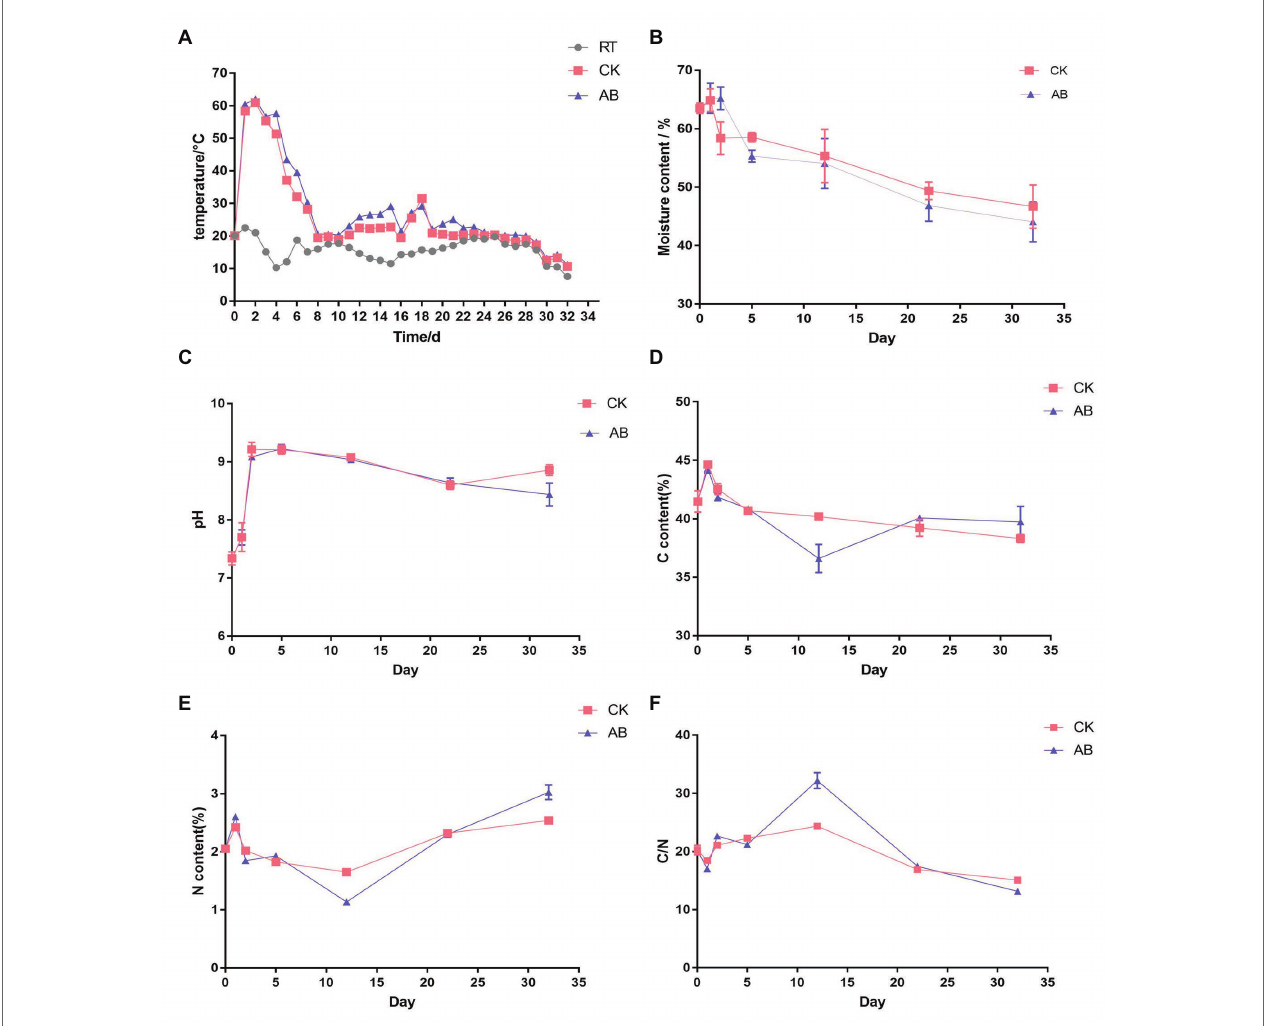
FIGURE 1 | Physicochemical changes during swine manure composting. (A) Temperature, (B) moisture, (C) pH, (D) TC, (E) TN, and (F) C/N in the two treatment conditions during the composting process. CK: the swine manure composting. AB: add 1% compound microbial agents in the swine manure